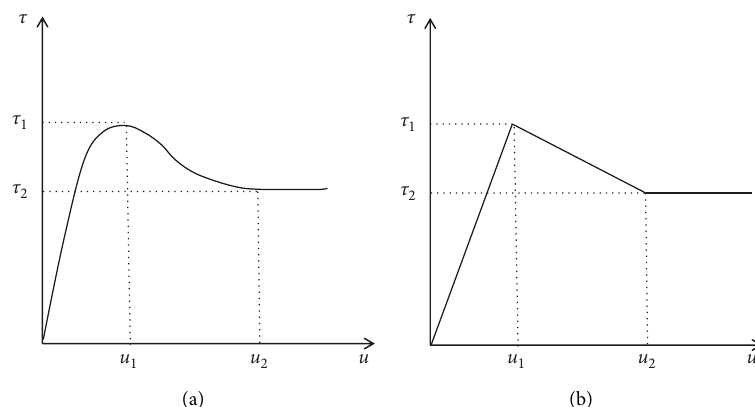
Figure 7: Strain-softening model of geogrid-soil interface. (a) Curve relationship of shear stress-displacement. (b) Trilinear softening model.